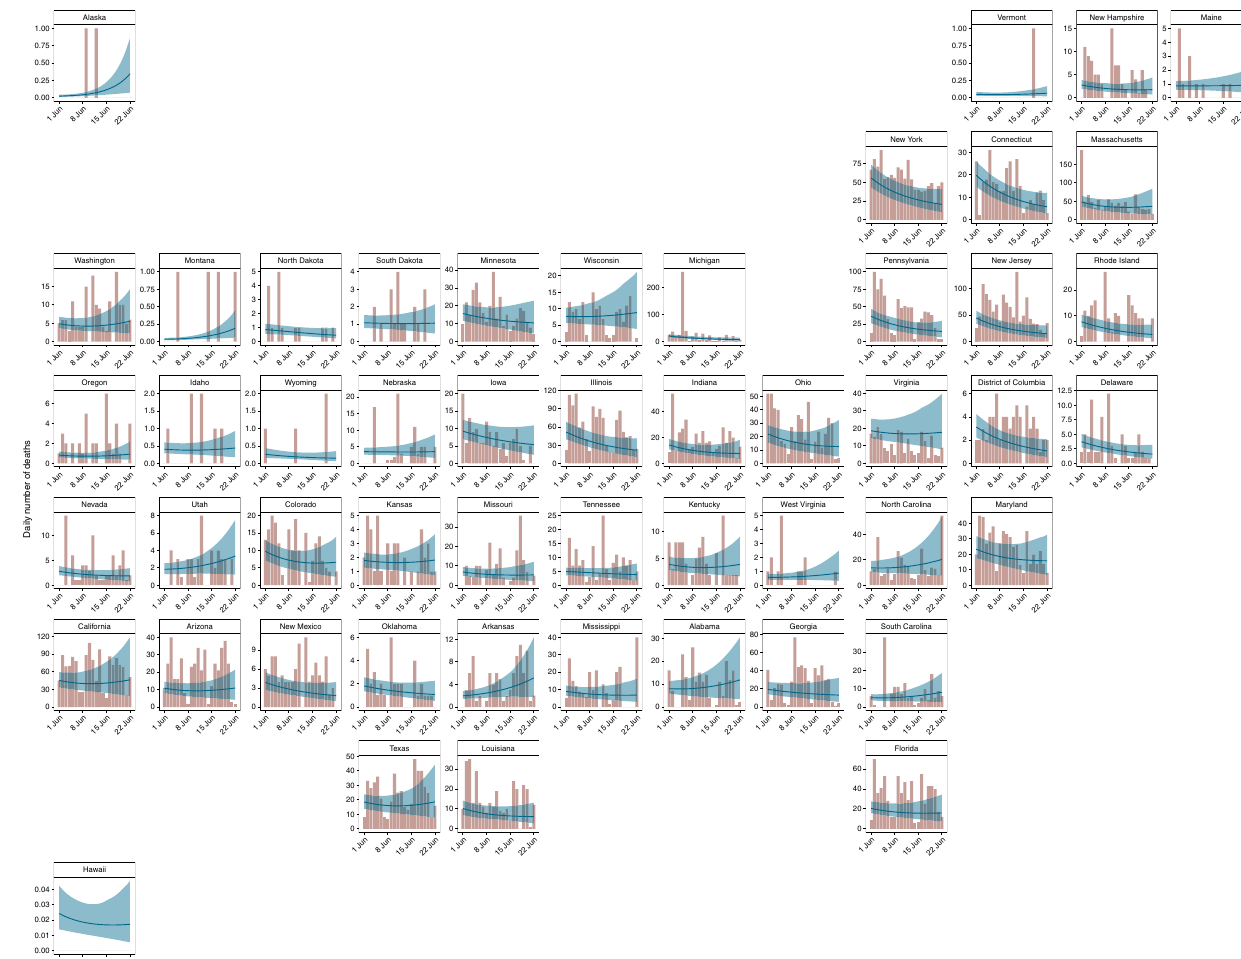
Fig. 4 Three-week death forecasts for model fi tted up until 01 June 2020. The coral bars show the reported number of deaths for the 3 weeks after 01 June 2020, and the blue line and ribbon show the mean and 95% CI for our forecast